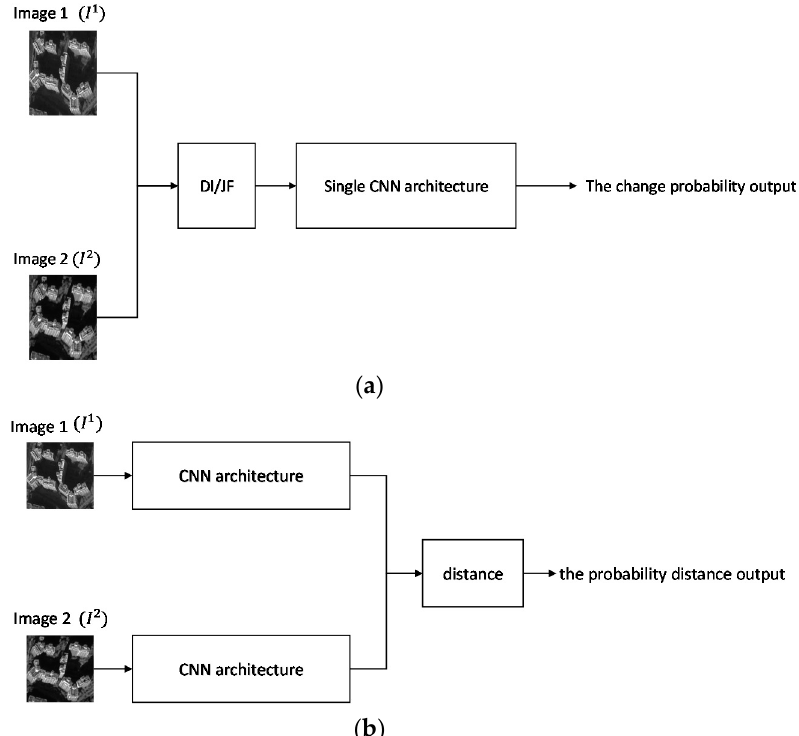
Figure 2. Front-end differential network (FDN) and back-end differential network (BDN) architectures: ( a ) Difference image (DI)/Joint features (JF) + single CNN, and ( b ) Dual-CNN.